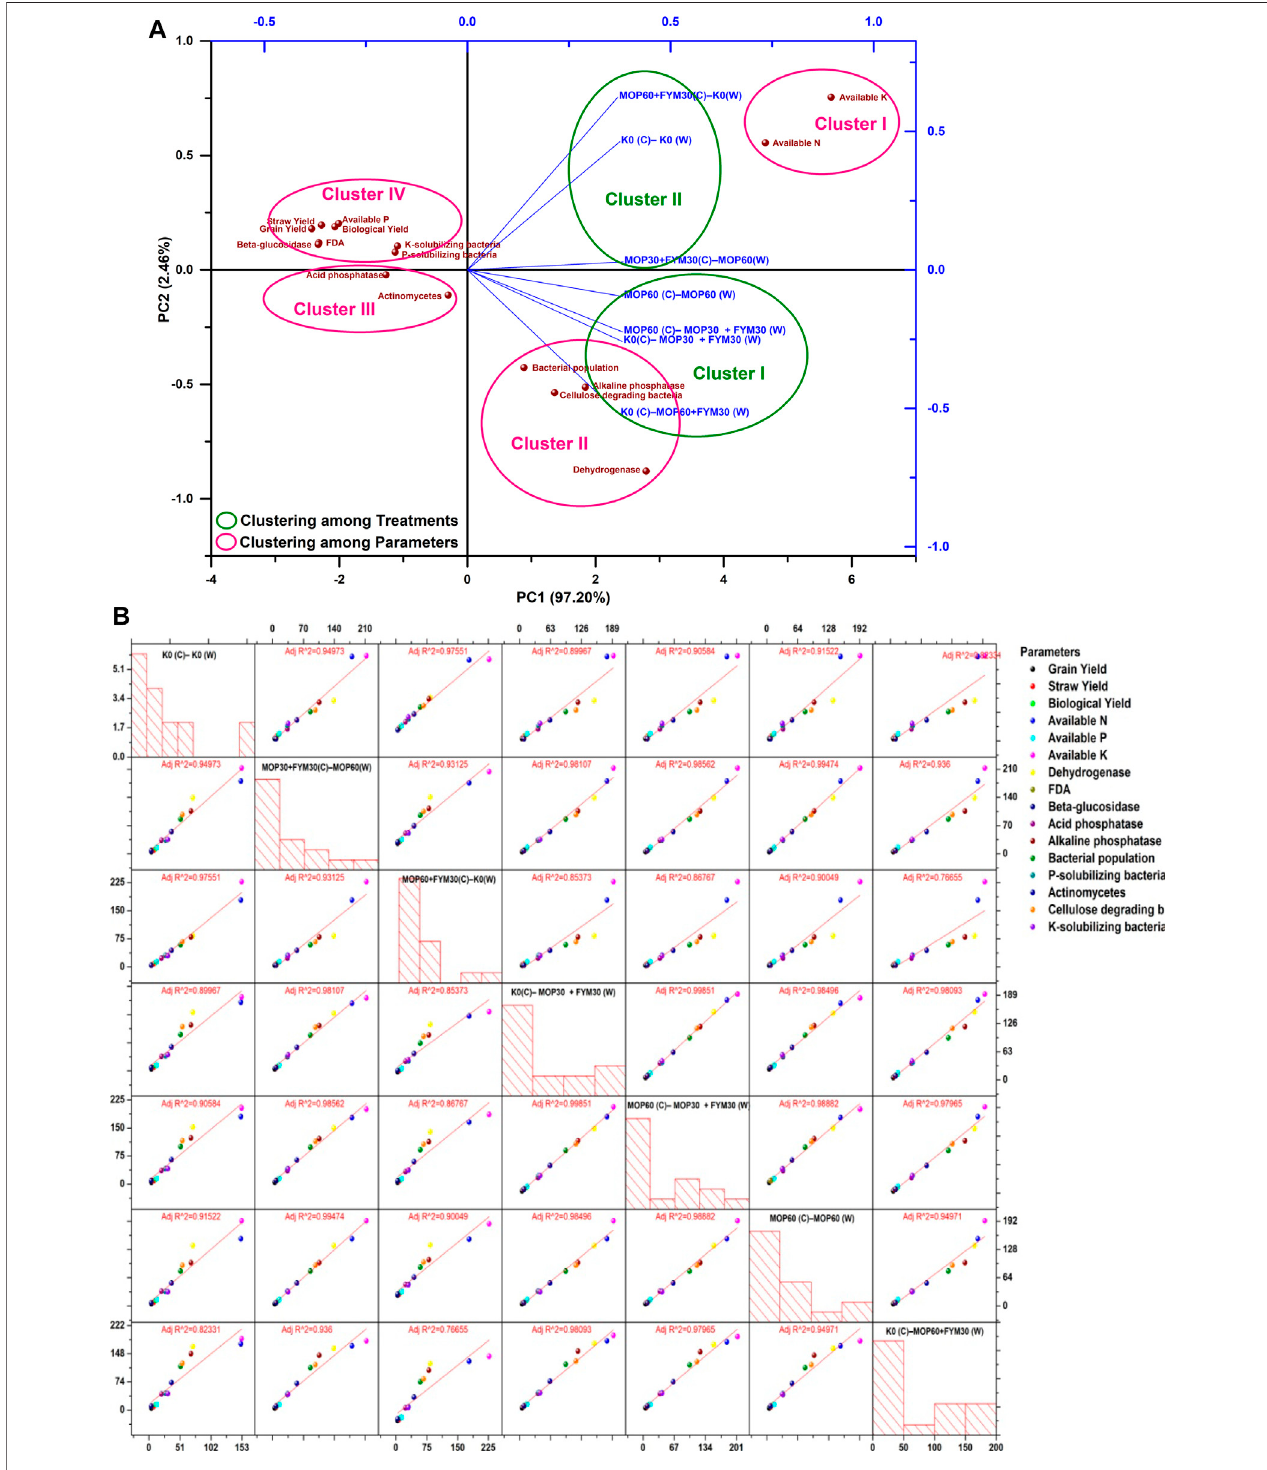
FIGURE 6 | (A) Principal component analysis among various parameters and treatments in the second year of wheat cultivation. (B) Scatter plot matrix and regression analysis among various parameters and treatments in the second year of wheat cultivation.